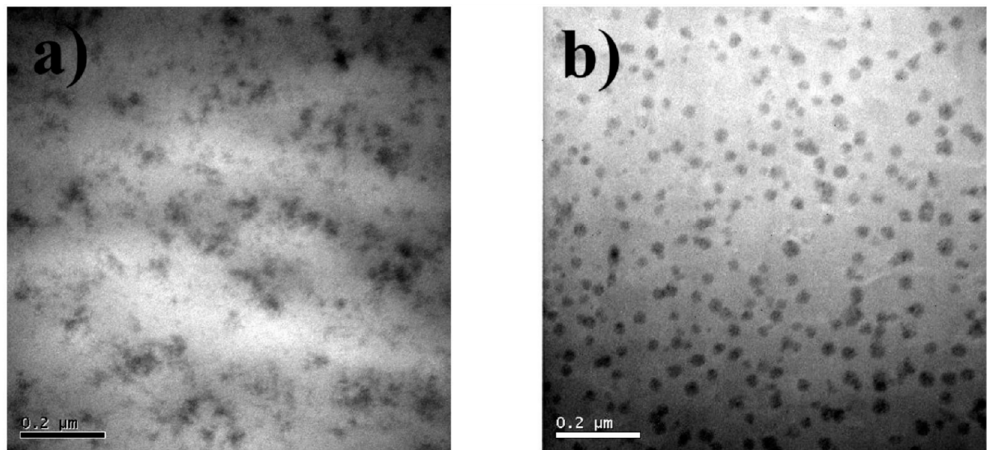
Figure 9. TEM images of the ( a ) epoxy–SiO 2 ; and ( b ) epoxy–TiO 2 nanocomposites prepared with GPTMS as coupling agent. Reproduced with permission from Wu and Hsu, The Journal of Physical Chemistry C ; published by American Chemical Society, 2010.